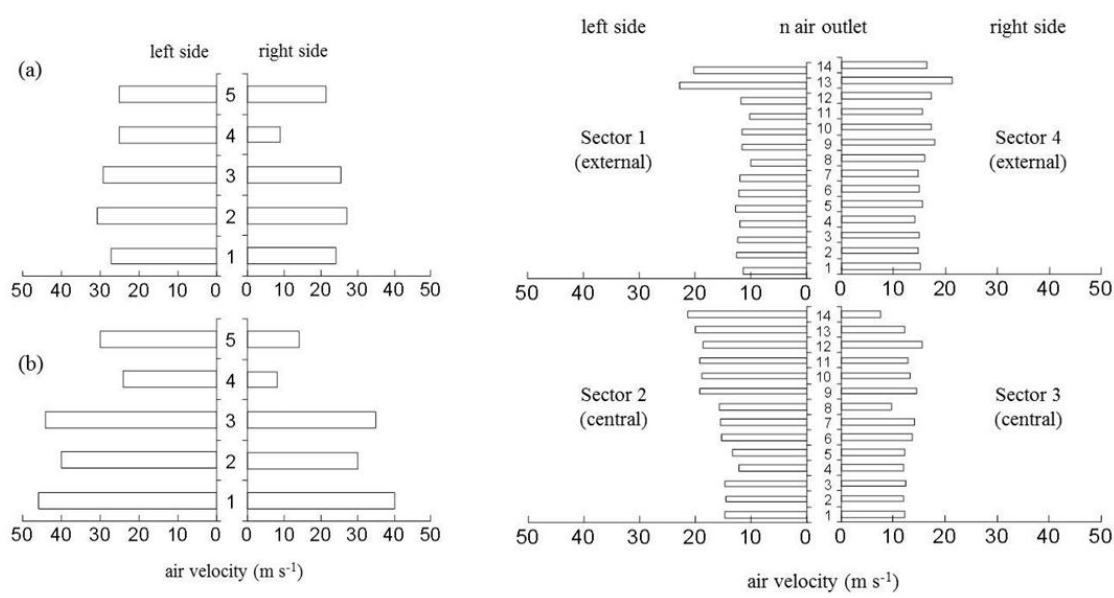
Figure 7. Air velocity profiles generated with the two sprayers. Left: conventional mist- blower at ( a ) low and ( b ) high air flow rate. Right: multi row sprayer at low air flow